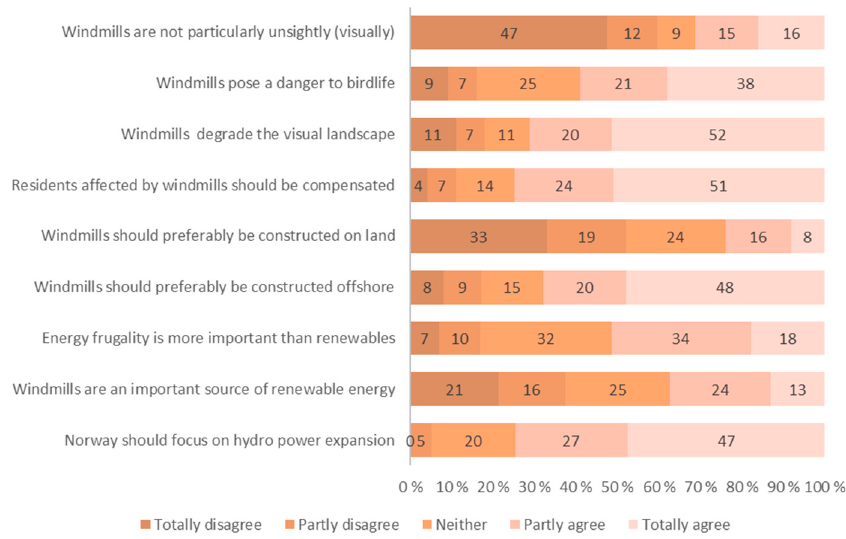
Figure 4. Respondents who agree or disagree to a set of prepared opinion statements. General context. n = 90.